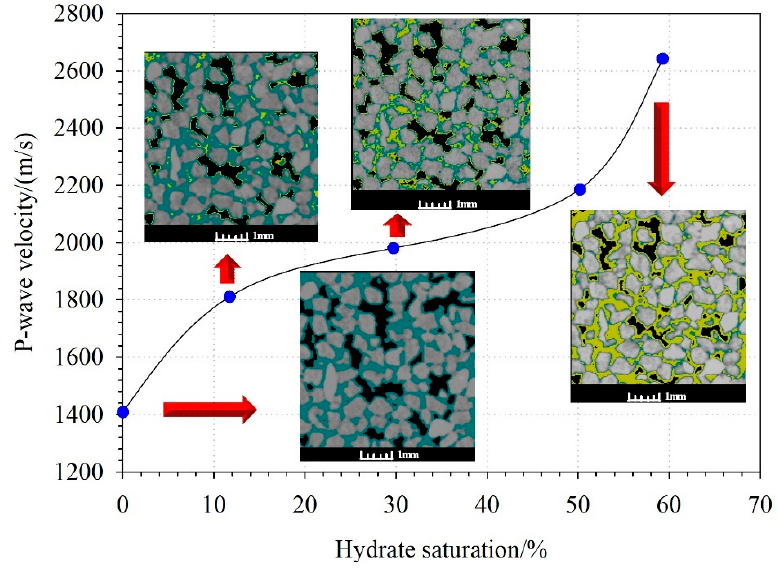
Figure 10. Variation of the microscopic spatial distribution and acoustic characteristics during hydrate formation. The yellow represents methane hydrate, the blue represents NaCl solution, the light gray represents sand, and the black represents methane gas.